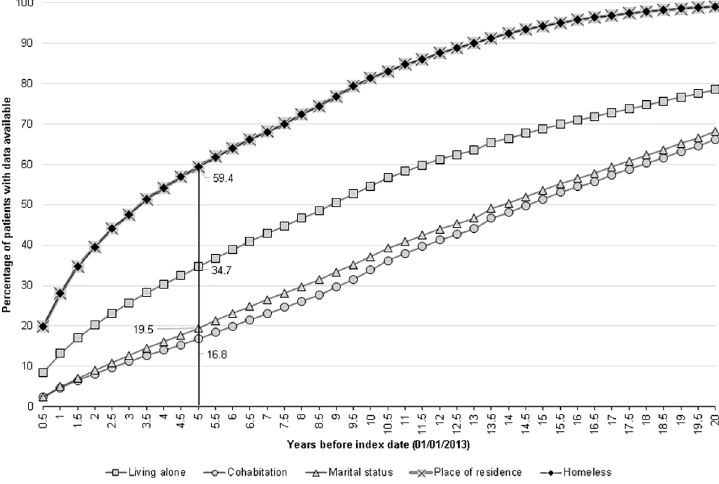
Fig 4. Timeliness of recording of living alone, cohabitation, marital status and place of residence. * datafrom family number analysisexcluded